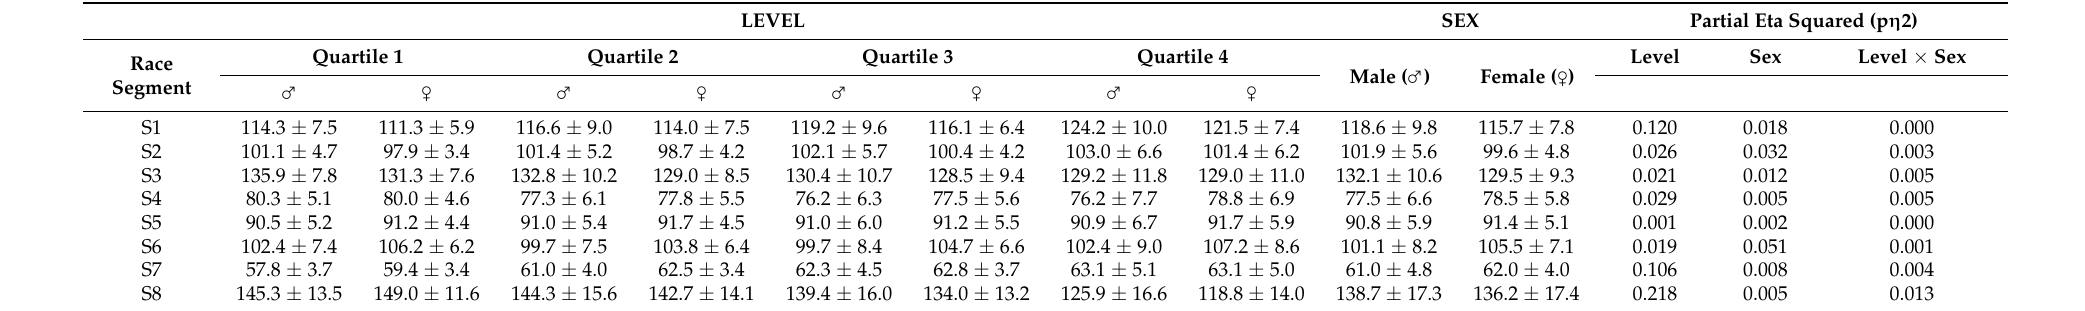
Table 2. Relative pace (%) in the different race segments (S1–S8) of males ( editions of the OCC ® , according to their performance levels (Quartile 1–Quartile 4). Effect size of the differences according to performance level, sex, and their interaction (level ×